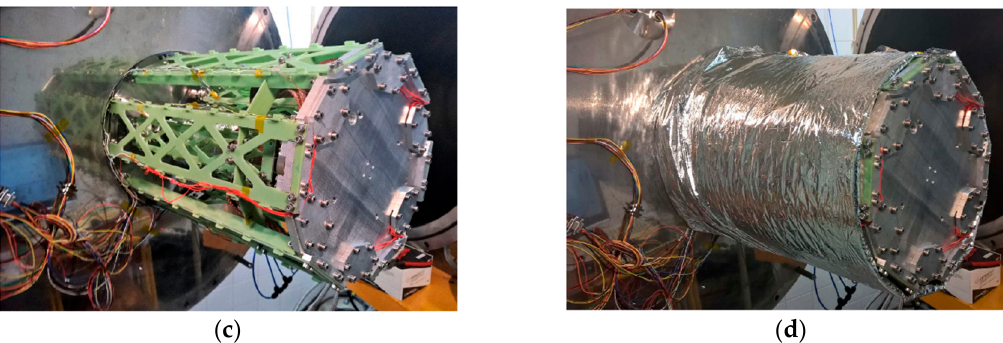
Figure 16. ( a ) Assembly of the outer epoxy, showing details of the thermal-mechanical switch (flexible bellow and inner epoxy). ( b ) System without the aluminum baseplate, showing the copper thermal interface of the pistons. ( c ) System with the aluminum baseplate. ( d ) System with the aluminum baseplate and MLI [12].